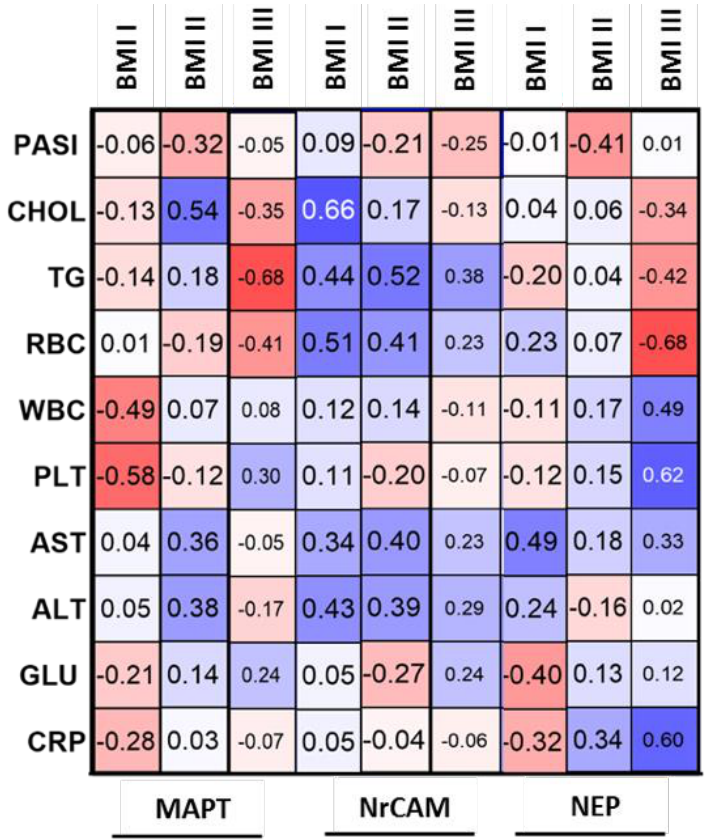
Figure 3. Correlations between evaluated proteins and selected laboratory parameters with regard to BMI subdivision before total treatment with use of Spearman ’ s rank correlation. The duration-based division of the patients group with a threshold of 20 years showed that the duration of psoriasis does not influence significantly MAPT level (Figure 4a).